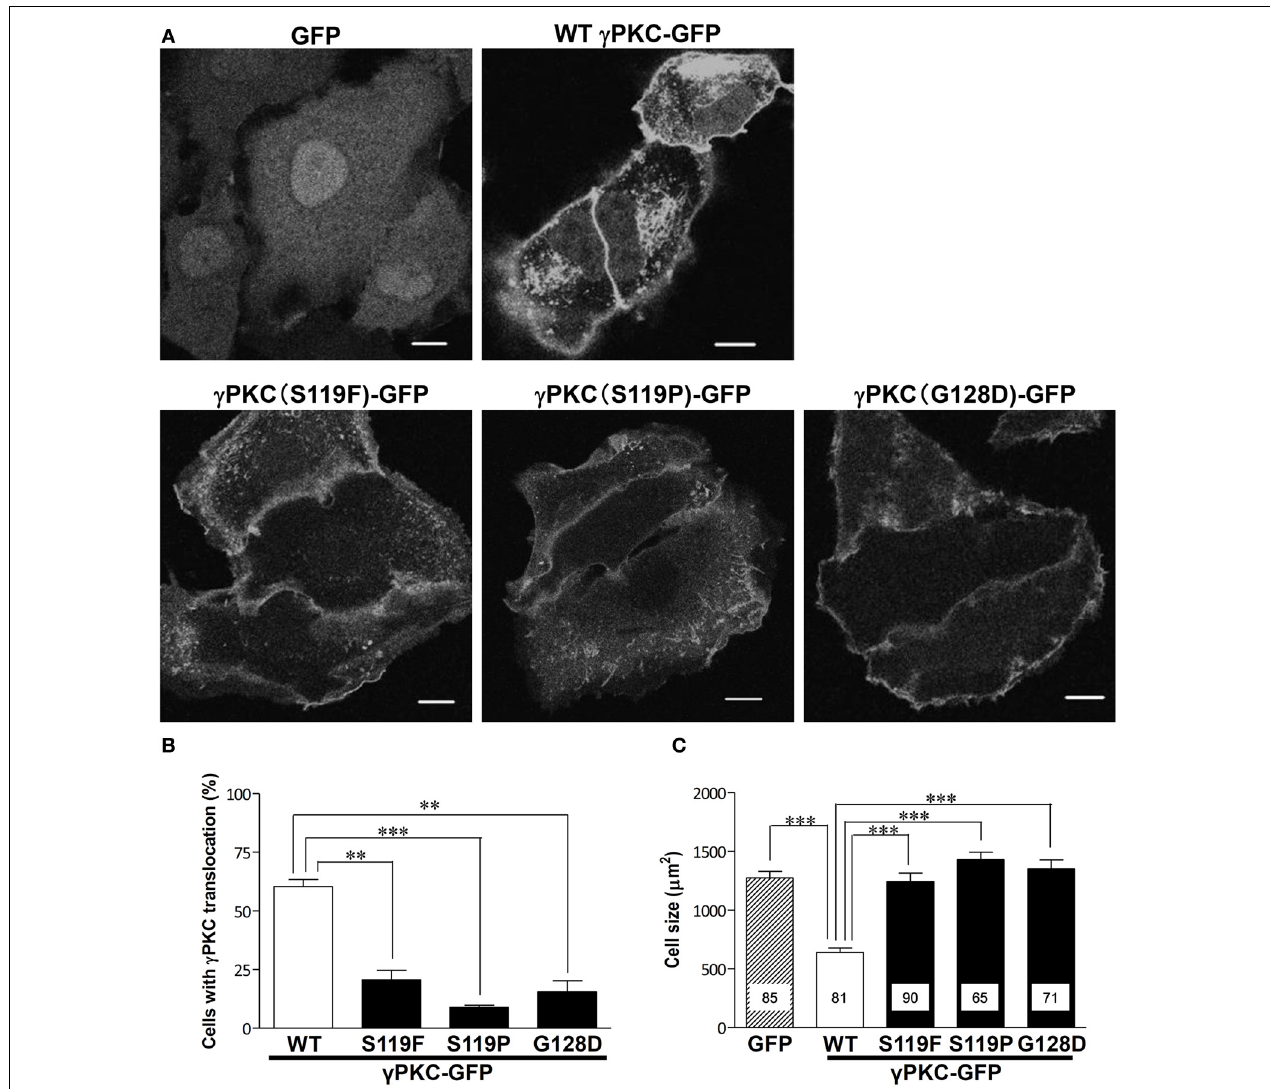
FIGURE 2 | SCA14 mutant γ PKC impairs the perinuclear translocation and cell size reduction in response to TPA treatment. (A) Representative fluorescence images of GFP (left), WT γ PKC-GFP (center) or S119P γ PKC-GFP (right)-expressing HeLa cells treated with TPA for 30min. In response to TPA treatment for 30min, WT γ PKC-GFP exhibited membrane translocation, followed by perinuclear translocation and a reduction in cell size. In contrast, S119P mutant γ PKC-GFP did not exhibit perinuclear translocation and remained at the plasma membrane. In cells expressing GFP alone, TPA did not induce the translocation of GFP or cell shrinkage. Scale bar = 10 μ m. (B, C) Quantification of the TPA-induced perinuclear translocation of γ PKC-GFP and cell shrinkage. (B) The percentage of γ PKC-GFP-positive HeLa